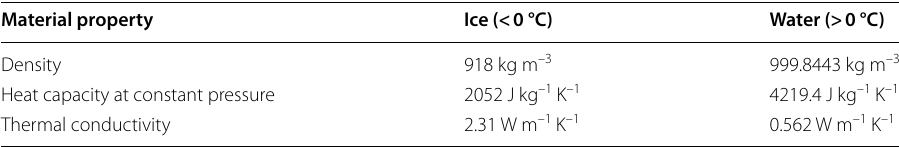
Table 2 Properties of water and ice above and below the freezing point Material